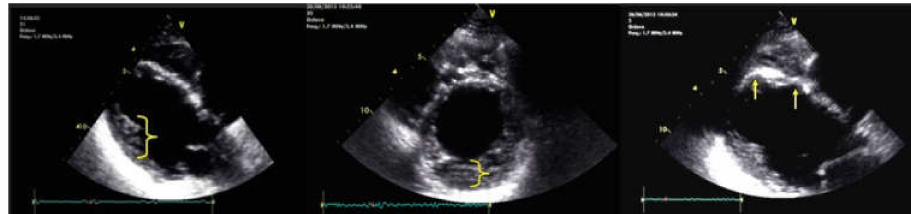
Figure 3. Cardiac ultrasound. Left image: long-axis parasternal section shows dilated LV, with hyperechoic thin SIV, and LV noncompaction areas at the posterolateral wall (brace); middle image: short axis parasternal section displays noncompact LV area (brace) > 2 × compact LV area; right image: parasternal section long axis shows aneurysms located at the SIV level (arrows). The CMRI highlighted the following: biventricular dilatation (LV = 52/58 mm; RV = 53 mm short axis base), global hypokinesia of the LV and RV, with small akinetic area in the IVS (Figure 4D), focal dyskinetic areas in the RVOT (Figure 4A), anterior wall